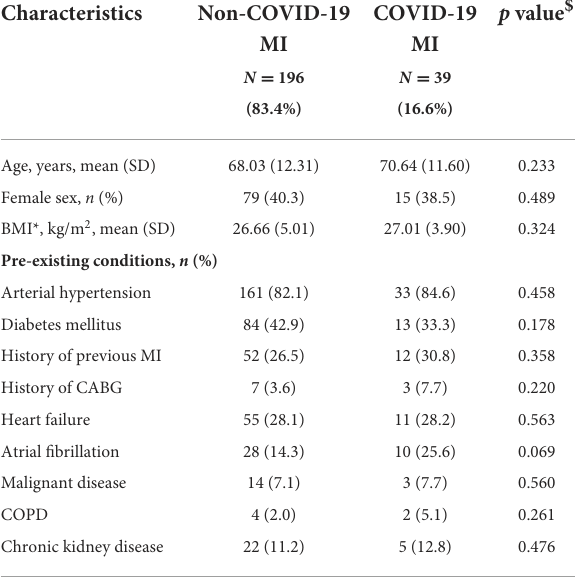
TABLE 1 Basic characteristics of